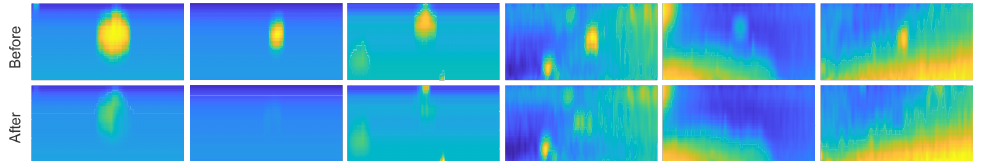
Figure 4. Overview of the picking process. Multiple different colonies are plotted before ( top ) and after ( bottom ) the picking process.